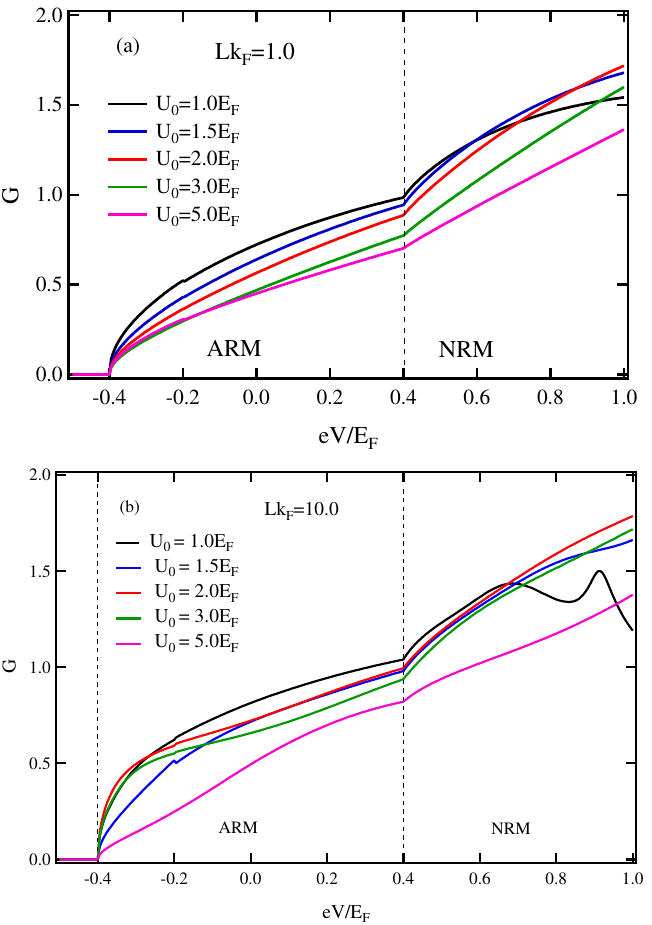
Figure 4. (Color online) Conductance spectra in the applied voltage for different values of the barrier potential in case of E α < M 2 . ( a ) Lk F = 1.0, ( b ) Lk F = 10.0. Here, the parameters were set as m R = m FM , M 2 = 0.4 E F and E α = 0.2 E F